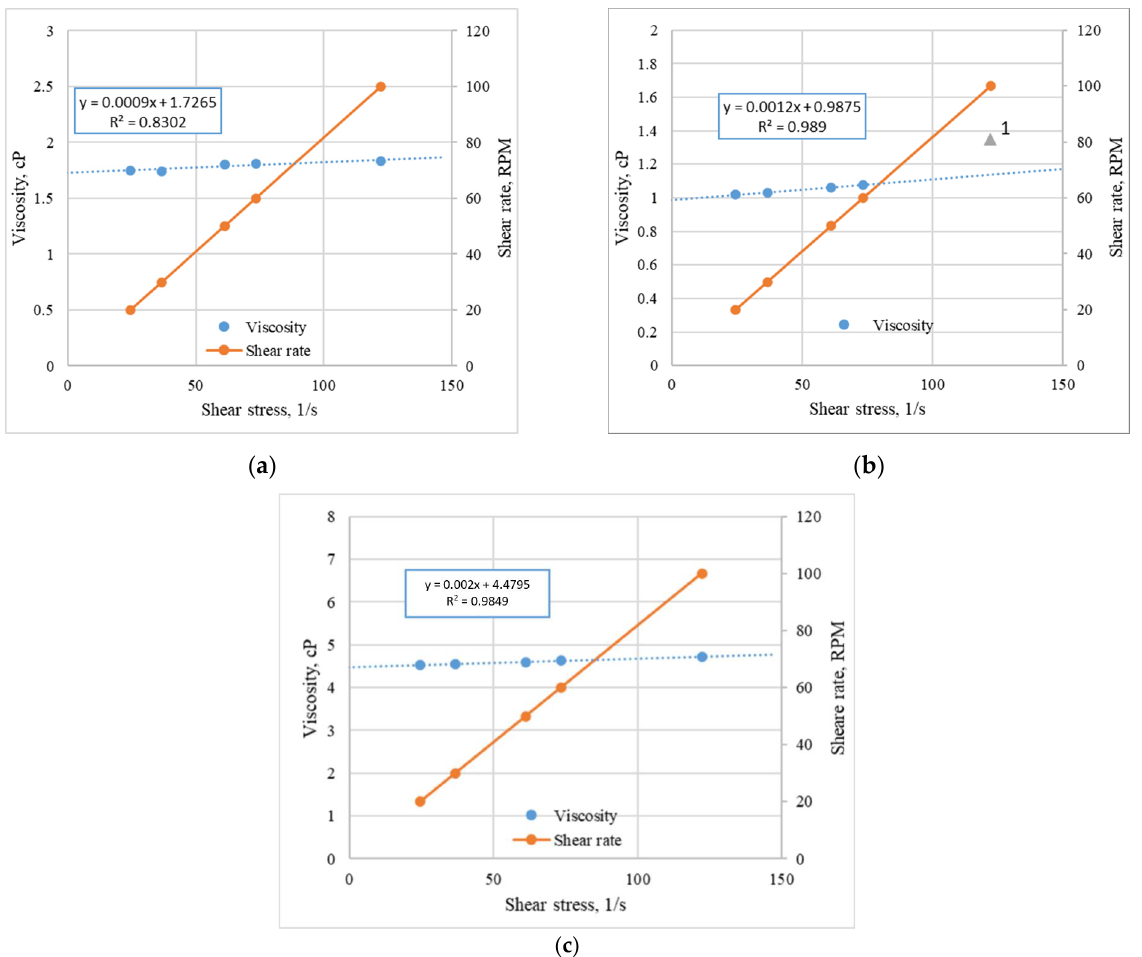
Figure 6. Dependence of the viscosity on the shear rate of destroyed samples: “crosslinked” guar gel ( a ); non-polymer composition based on VES ( b ); liquid based on synthetic polymers ( c ). 1 Possible experimental